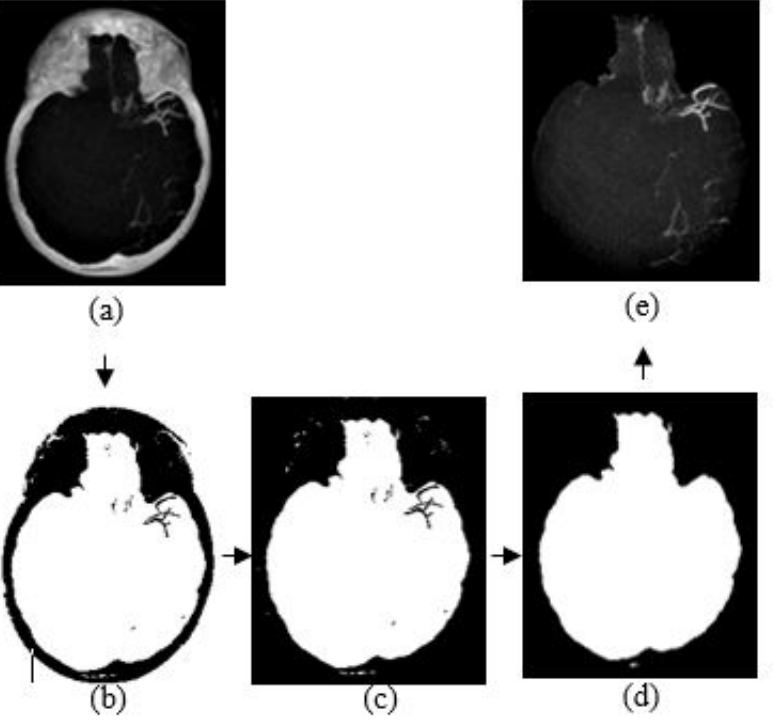
Figure 4. The algorithm of skull removal. ( a ) MIP input image, ( b ) binary image, ( c ) removing object touching the binary image boundary, ( d ) mask image, and ( e ) region of interest, masked out from mask